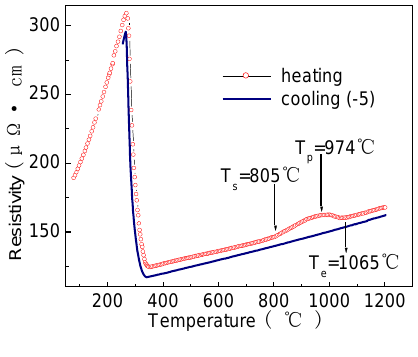
Figure 10. ρ- T curves of